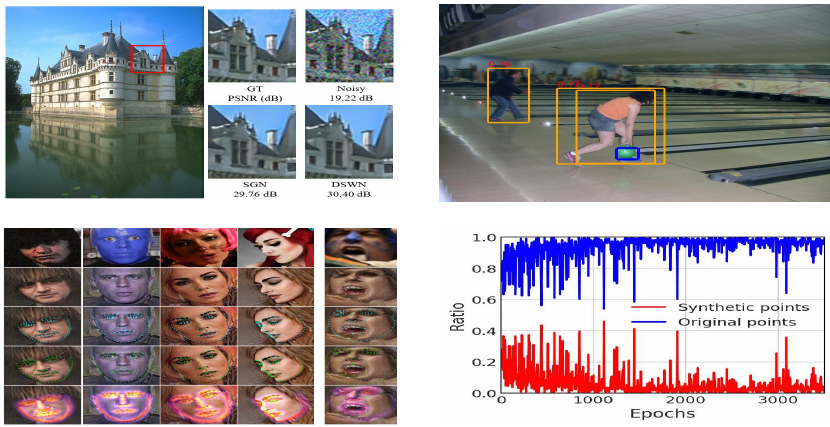
Figure 5. Examples of the PaperNet_CV dataset figures.